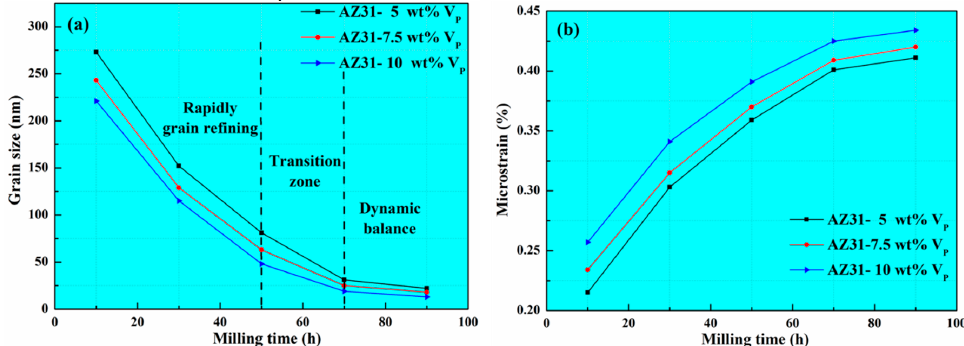
Figure 6. The grain size ( a ) and microstrain ( b ) of AZ31 ‐ X wt % V P (X = 5, 7.5, 10) powders after milling for different times.